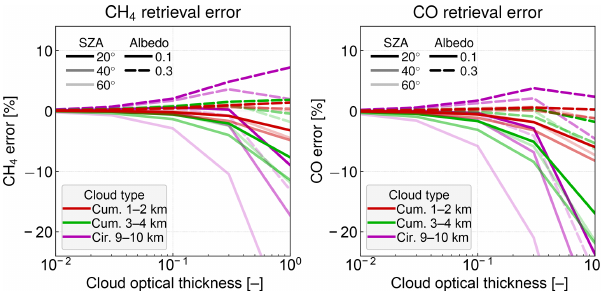
Figure 5. Systematic retrieval errors for different water clouds (cum.) and ice clouds (cir.) under various